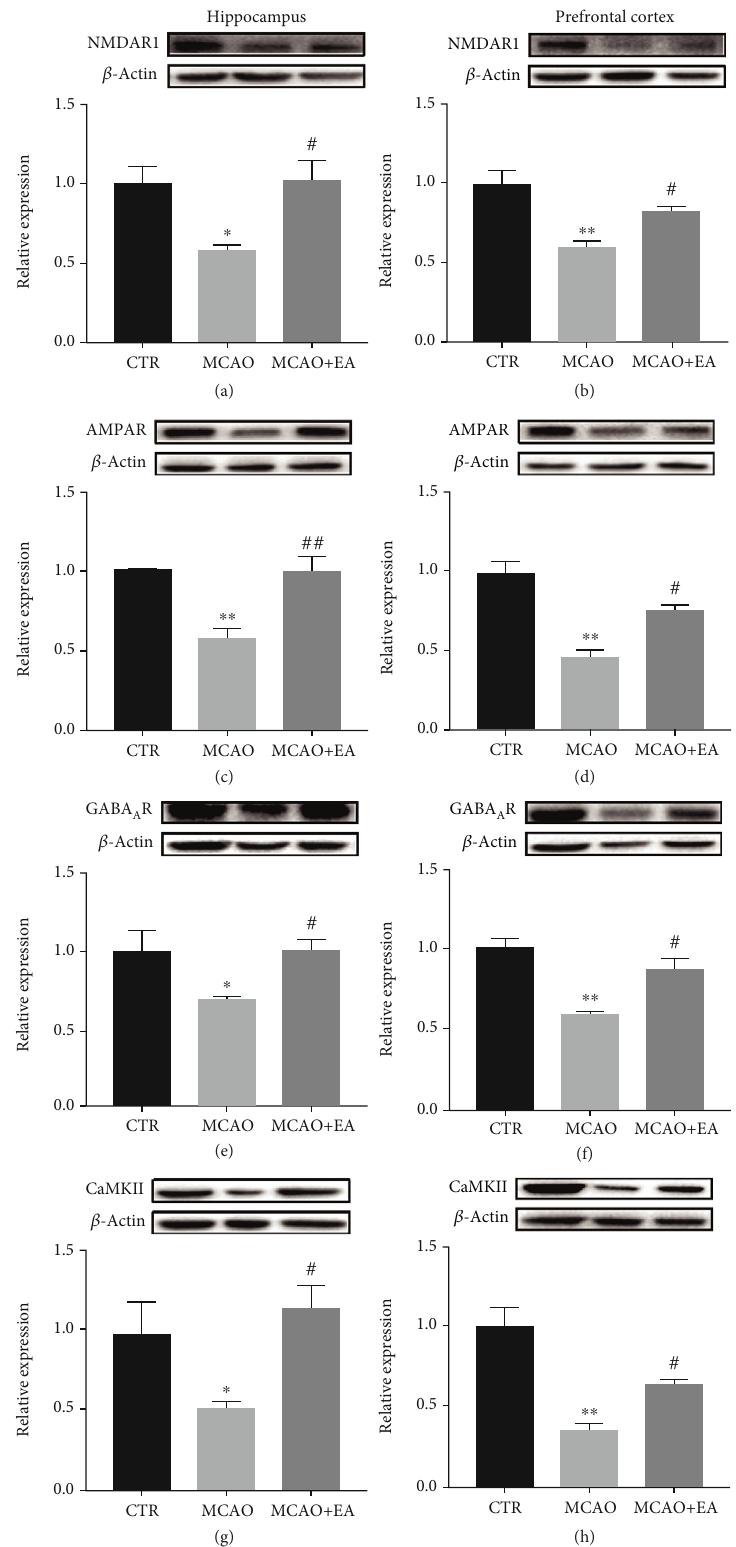
Figure 7: E ff ects of the MCAO and EA in neurotransmitter receptor proteins. NMDAR1 (a, b), AMPAR (c, d), GABA (g, h) in the hippocampus and PFC, measured using Western blot analysis. Value is expressed as mean ± SEM , where ∗ p < 0 : 05 and ∗∗ p < 0 : 01 compared to the control group and # p < 0 : 05 and ## p < 0 : 01 compared to the MCAO group ( n ≥ 3 each group). CTR: control; MCAO: middle cerebral artery occlusion; EA: